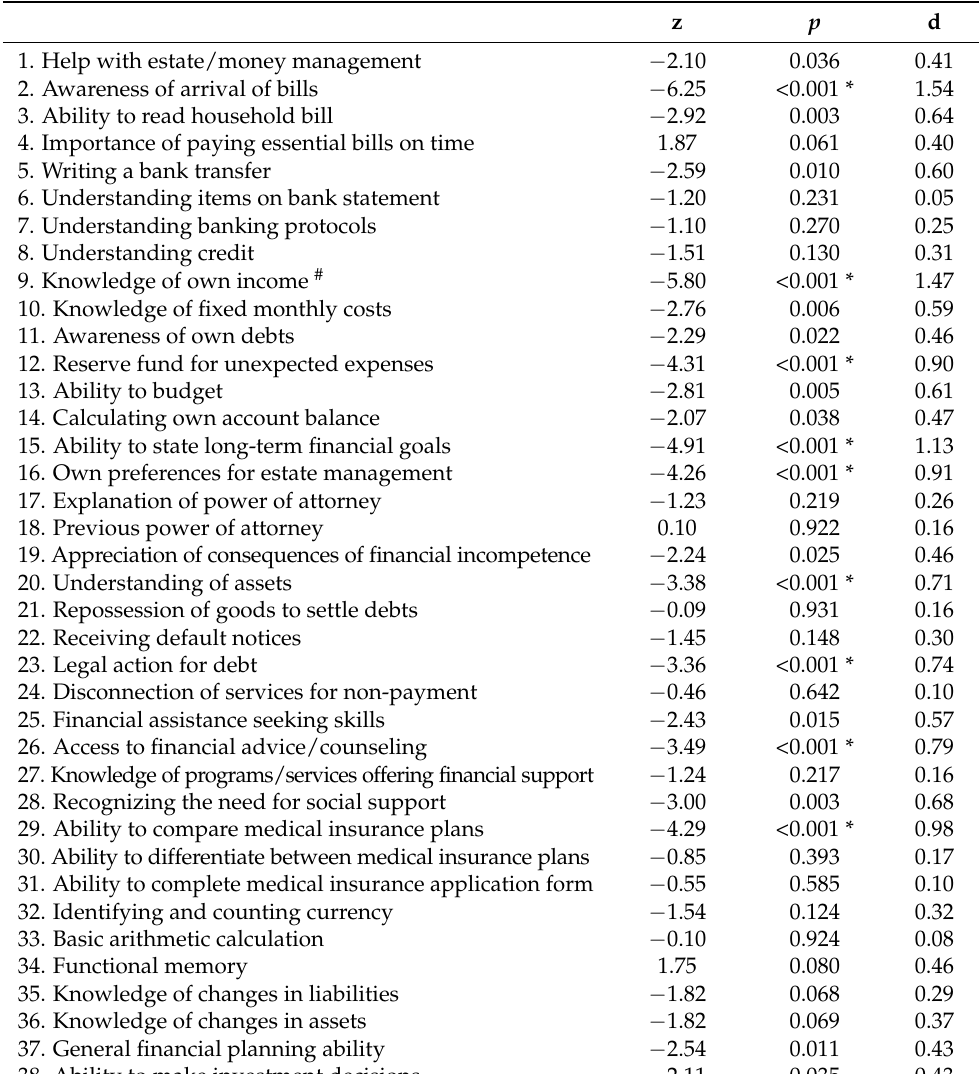
Table 3. Comparison of performance on FCAI items of adults with ( n = 45) and without ADHD ( n = 47).